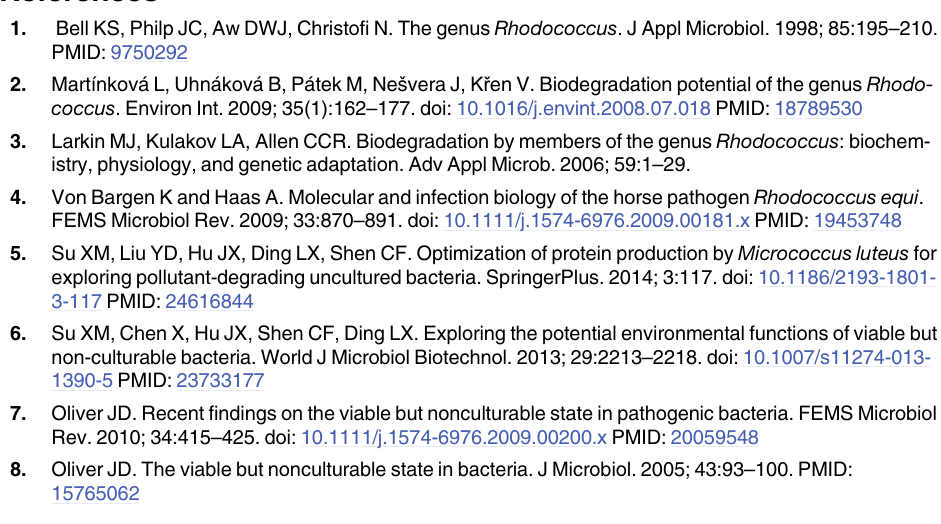
S1 Table. qPCR primers used in this study. S2 Table. Gene expression value of annotated genes. S3 Table. Differentially expressed genes. S4 Table. Genes > 20 fold up- or down-regulated. S5 Table. Gene Ontology function of differentially expressed genes. S6 Table. GO enrichment analysis of up and down-regulated genes in t_TG13 versus c_TG13 cultures. S7 Table. KEGG pathway enrichment of differentially expressed genes. S8 Table. KEGG enrichment analysis of up and down-regulated genes in t_TG13 versus c_TG13 cultures. S9 Table. qRT-PCR validation of transcriptomic